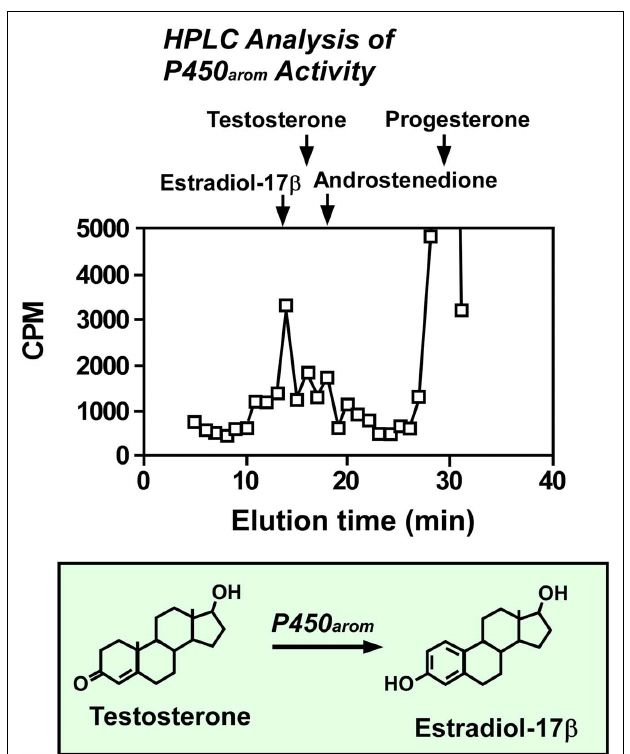
analysis of neurosteroids extracted from quail diencephalic slices after 60min incubation with 3 H-progesterone using a reversed-phase column. The column was eluted with a 30-min linear gradient of 40–70% acetonitrile, followed by an isocratic elution of 70% acetonitrile.The ordinate indicates the radioactivity measured in each HPLC fraction.The arrows indicate the elution positions of progesterone, androstenedione, testosterone, and estradiol-17 β . See Matsunaga et al. (2002) for